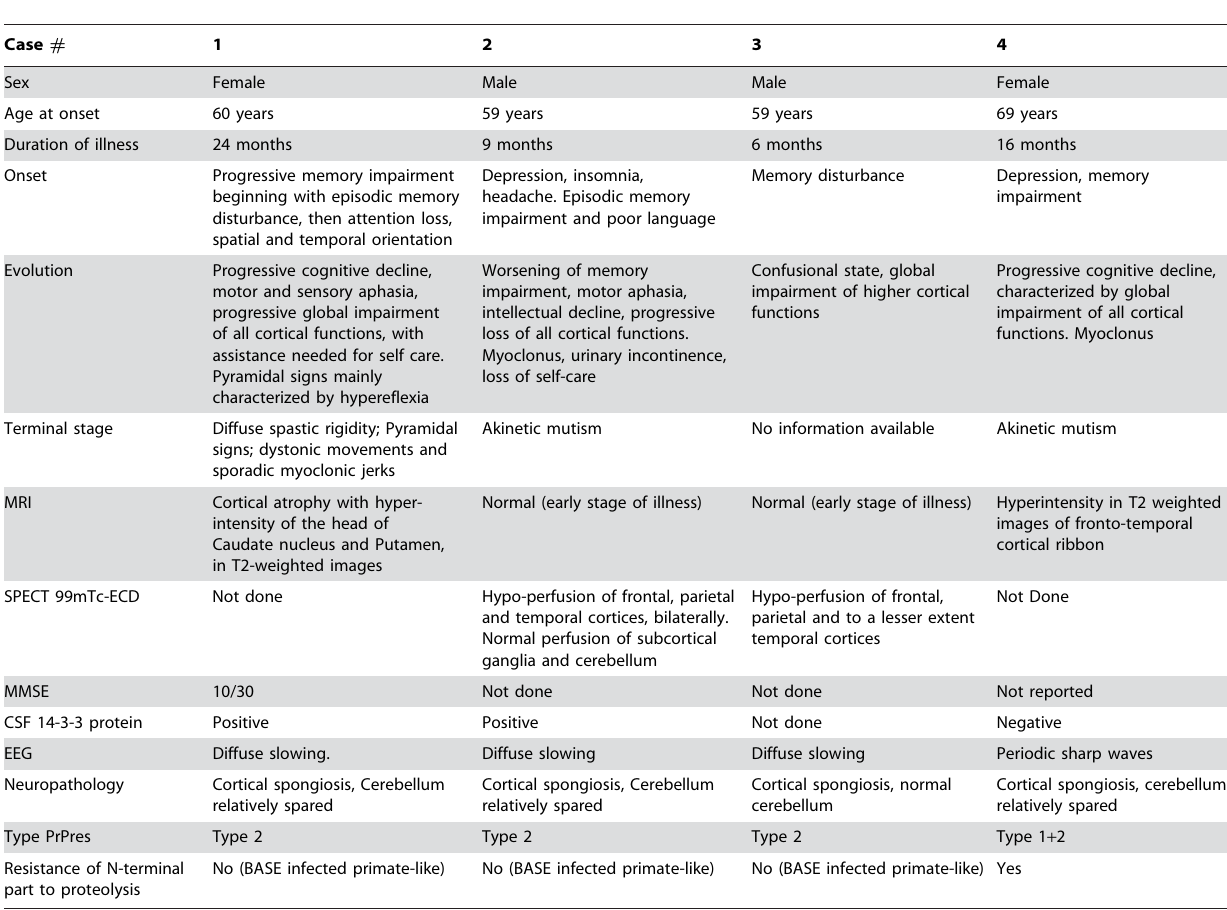
Table 2. Summary of MM2 subtype sporadic CJD